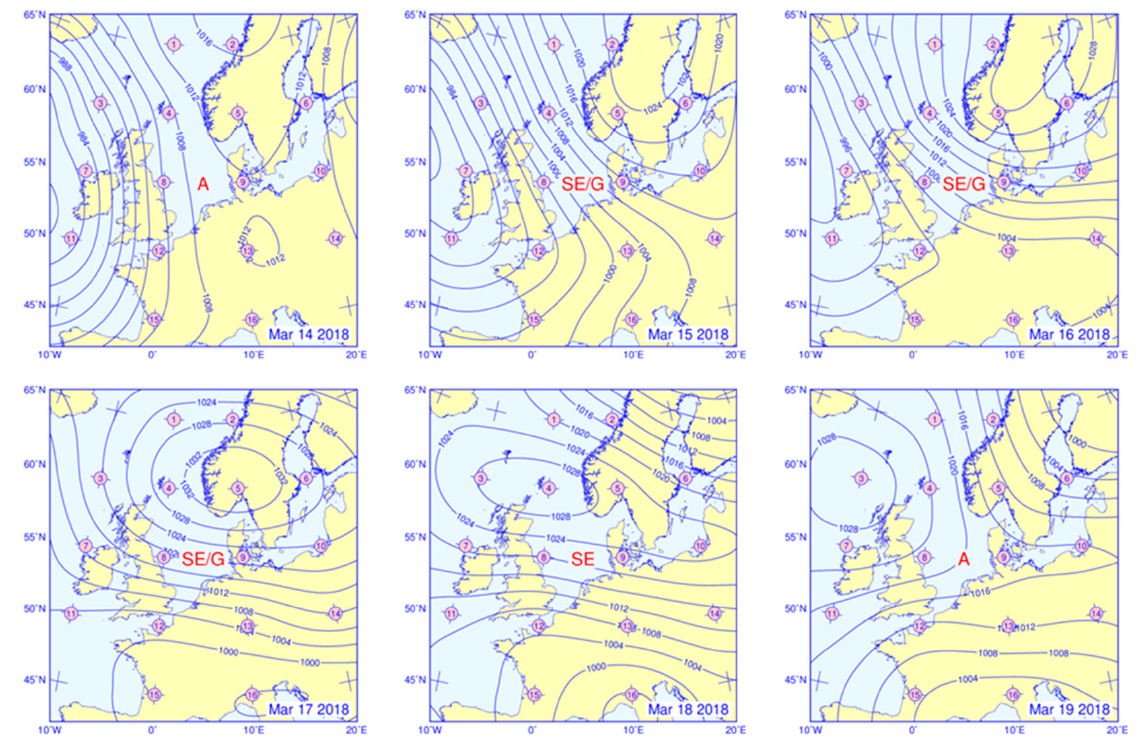
Figure 4. Sea level pressure fields for 14 March to 19 March 2018 with the respective LAMB weather types and gale indices derived from daily averages of ERA5 sea level pressure; the grid points used for the LWT classification (see also Figure 1a) are also marked again.